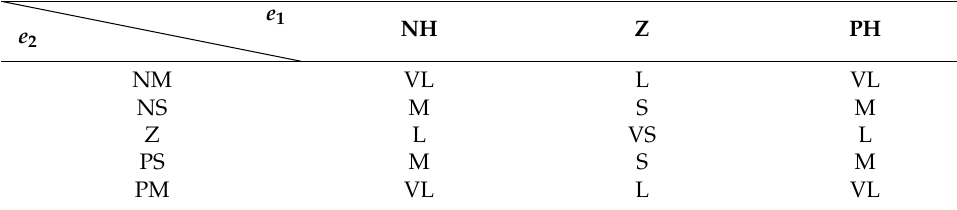
Table 1. Fuzzy rules for λ a .